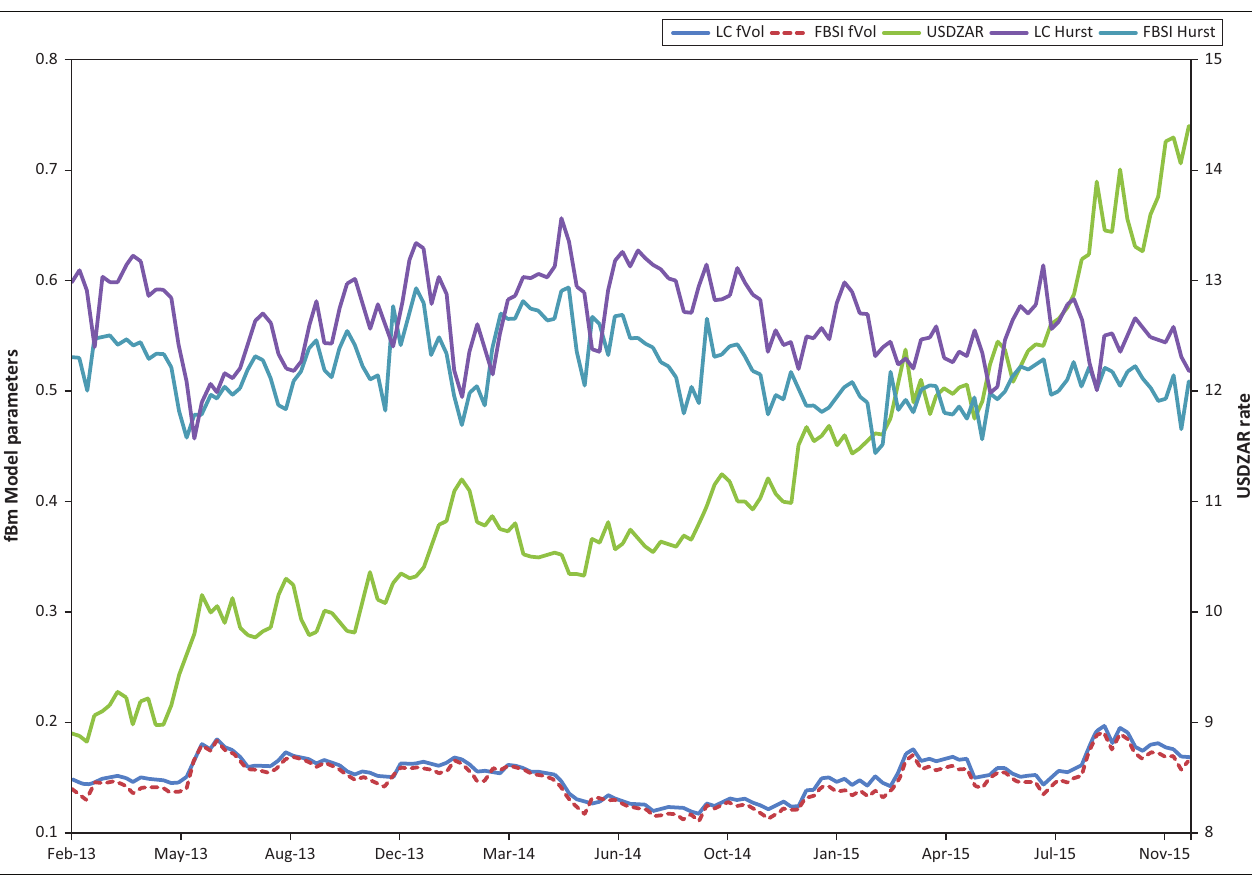
FIGURE 7: USD/ZAR performance plotted with the ATM fractional volatility and Hurst exponents from the calibrated FBSI and LC models, respectively, February 2013 to November TABLE 2: Correlation matrix of weekly log returns on USD/ZAR and associated implied volatility parameters, February 2005 to November 2015. Variable